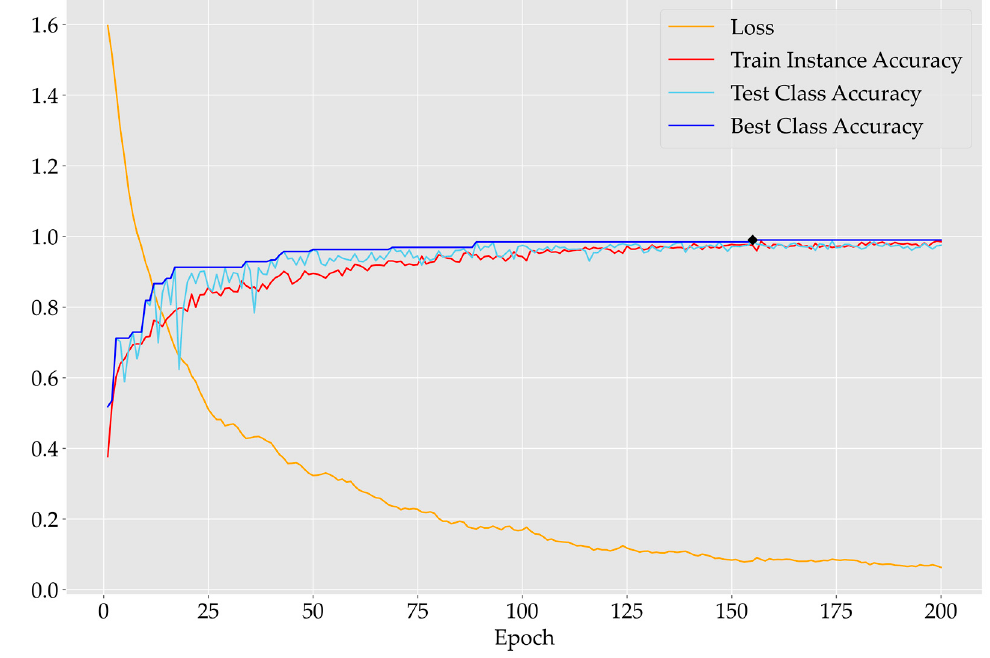
Figure 13. Changes in the loss function and accuracy during model training.